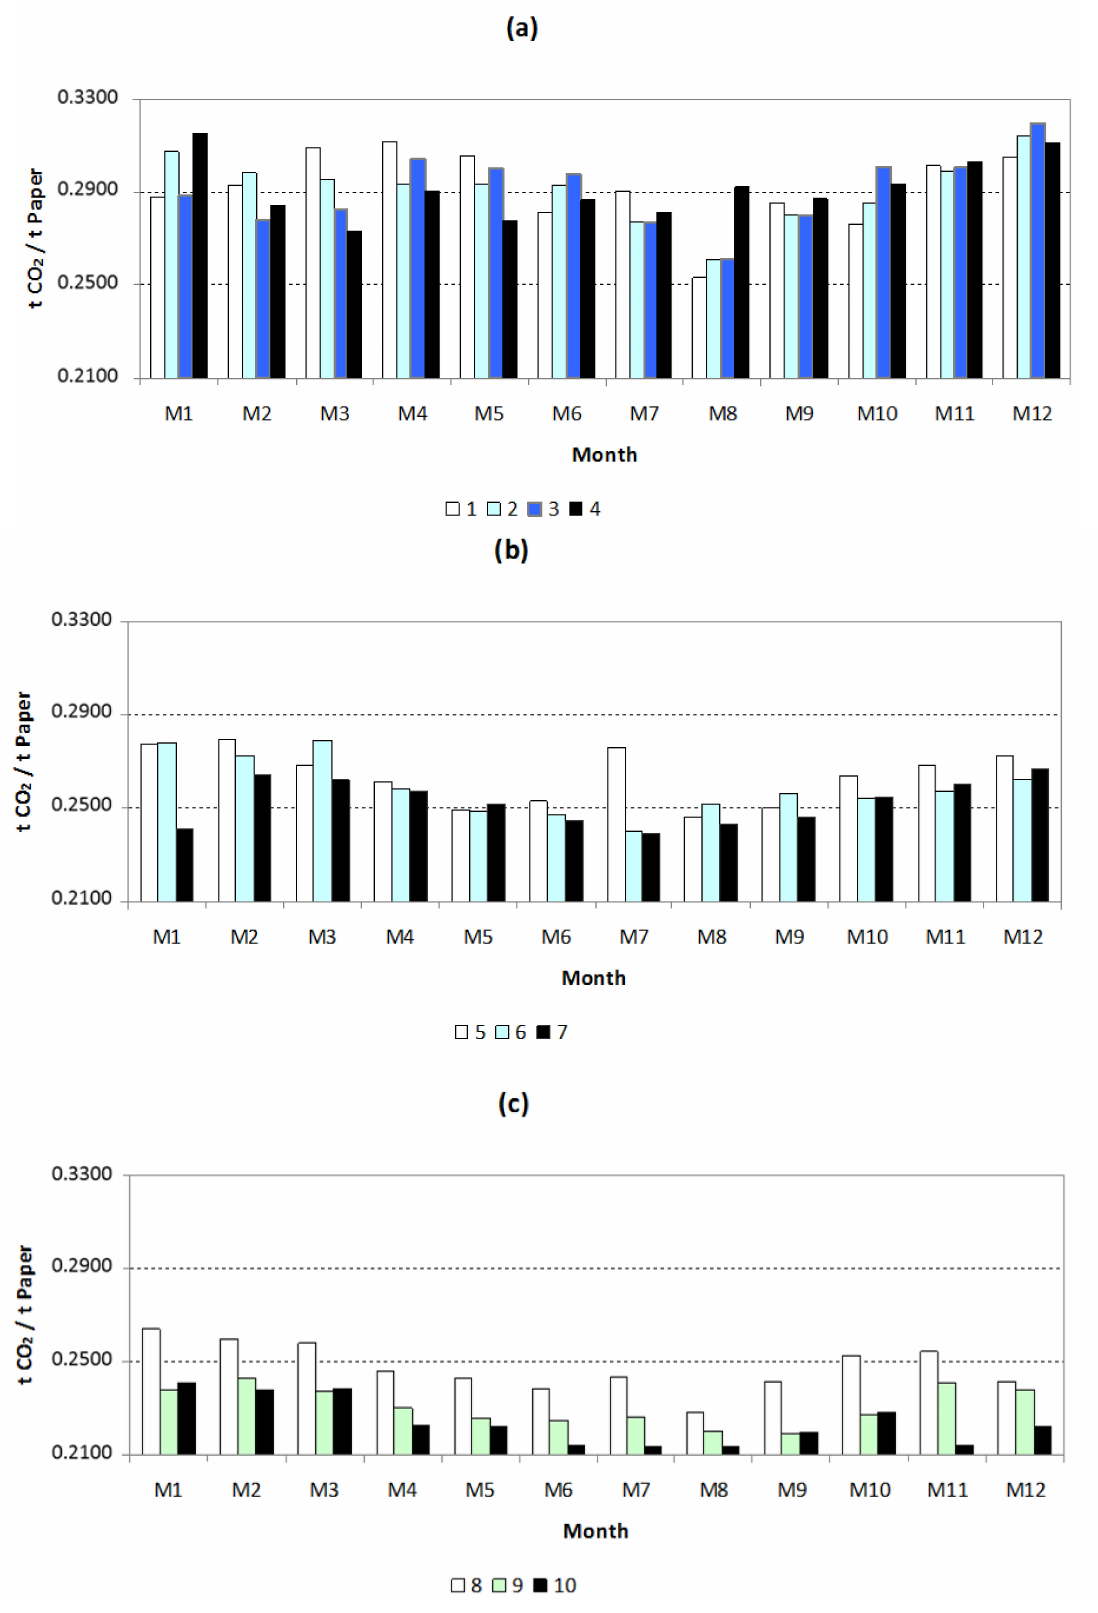
Figure 6. Monthly evolution of the indicator “t CO 2 /t Paper” over 10 years: ( a ) Years 1, 2, 3 and 4; ( b ) Years 5, 6 and 7; ( c ) Years 8, 9 and